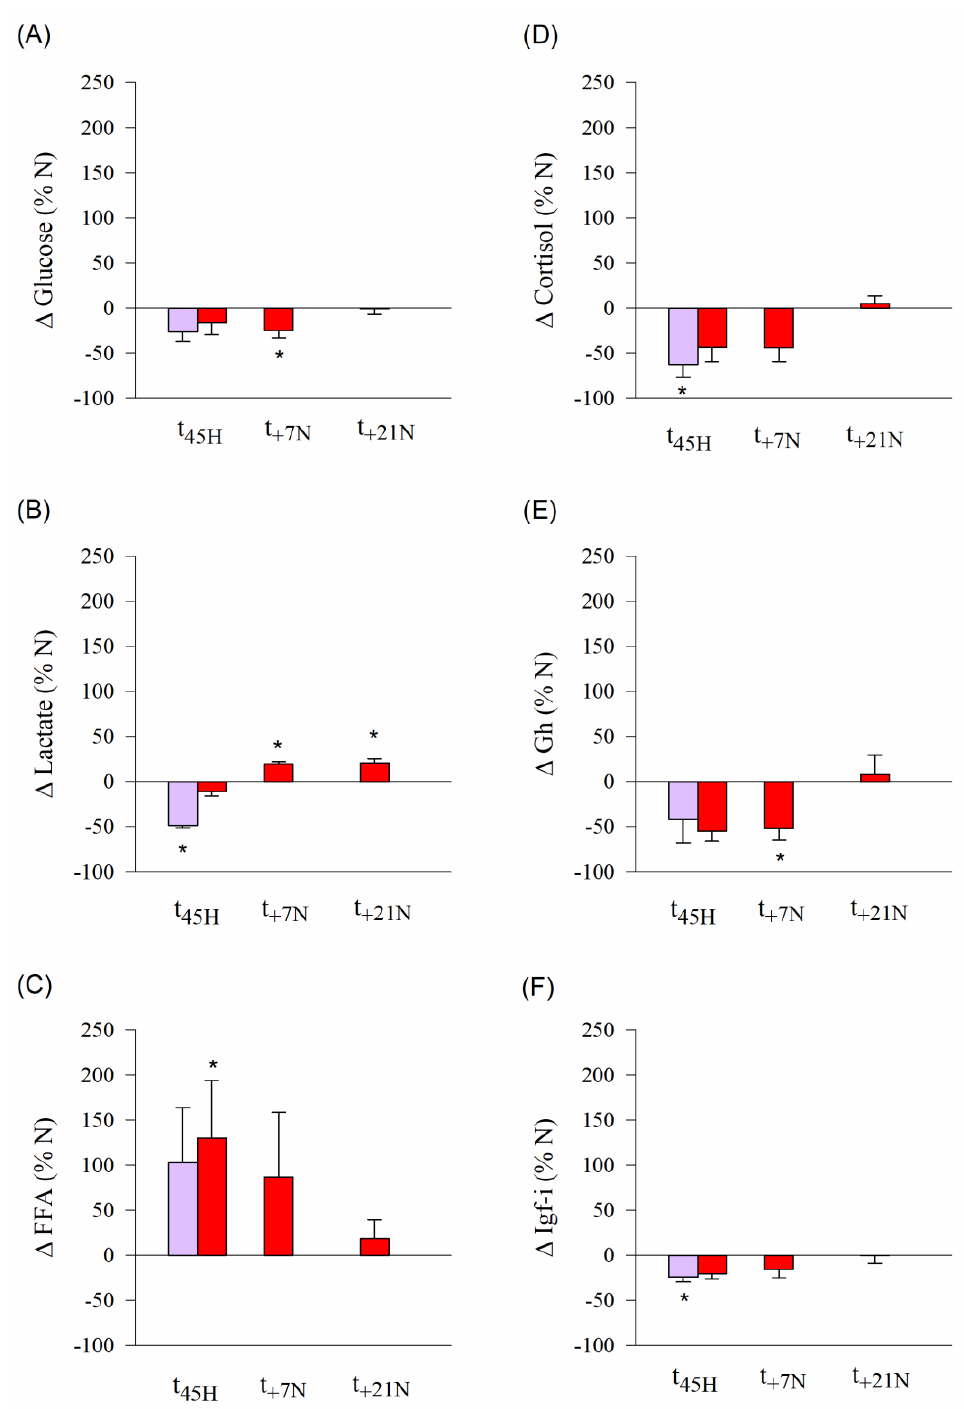
Figure 3. Changes in circulating levels of glucose ( A ), lactate ( B ), free fatty acids ( C ), cortisol ( D ), Gh ( E ), and Igf-I ( F ) in hypoxic (M-HYP, red) and pair-fed fish (N-PF, violet) following exhaustive exercise at the end of the mild-hypoxia conditioning period (t 45H ) and over the course of the normoxia recovery period (t +7N , t +21N ). Values are the mean ± SEM of 4–6 fish. Asterisks indicate statistically significant differences with N fish at each experimental time (SNK test, * p < 0.05; ** p < 0.01).